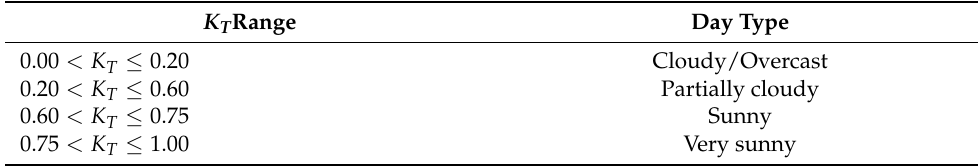
Table 4. Daily clearness index classification